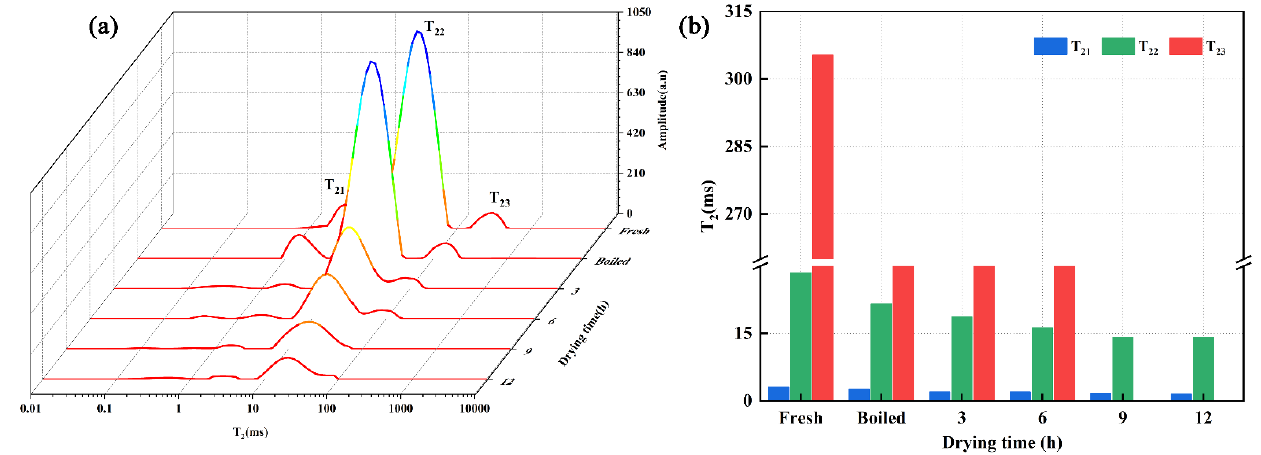
Figure 3. ( a ) Distribution of T 2 relaxation spectra and ( b ) change of T 2 relaxation times obtained by multi-exponential fitting of the continuously distributed Carr–Purcell-Meiboom-Gill relaxation curve of different shrimp samples during drying.